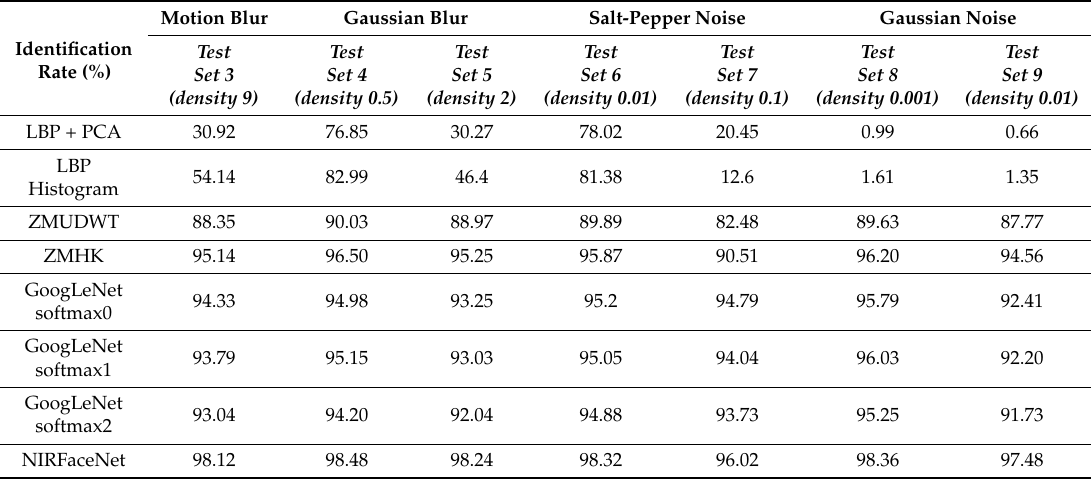
Table 5. Identification rate of algorithms tested on Test Sets 3–9 with different levels of blur and